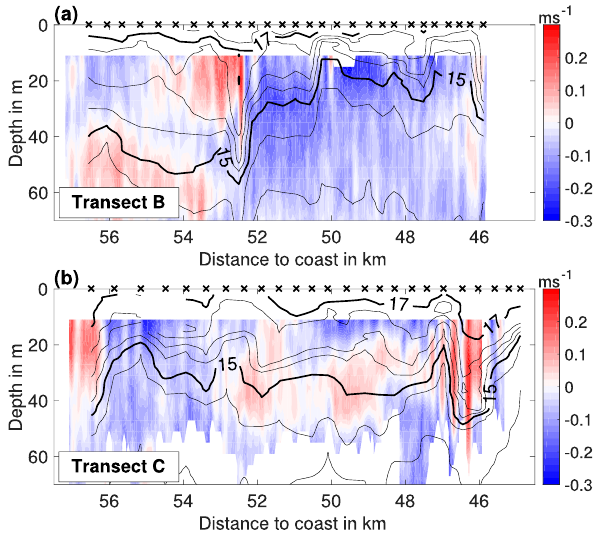
Figure 8. Temperature (black contour lines) and cross-front veloc- ity (color-coded) for Transects B (a) and C (b) conducted as the 12th and 14th cross-frontal transect, starting on 17 February 21:00 and 18 February 03:00, respectively. Black crosses show the loca- tion of the temperature profiles from the microstructure probe. For both transects the ship moved away from the coast (right to